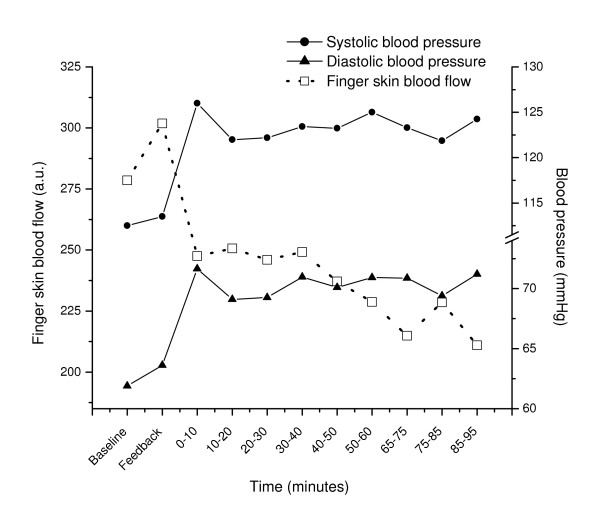
Mean blood pressure and finger skin blood flow (SBF) before (Baseline, Feedback), during (0–10, 10–20, .., 50–60 min) and after (65–75, 75–85, 85–95 min) the stressful task. Mean values for periods of 10 minutes (Baseline, Feedback: 5 min) are shown. Au = arbitrary units.